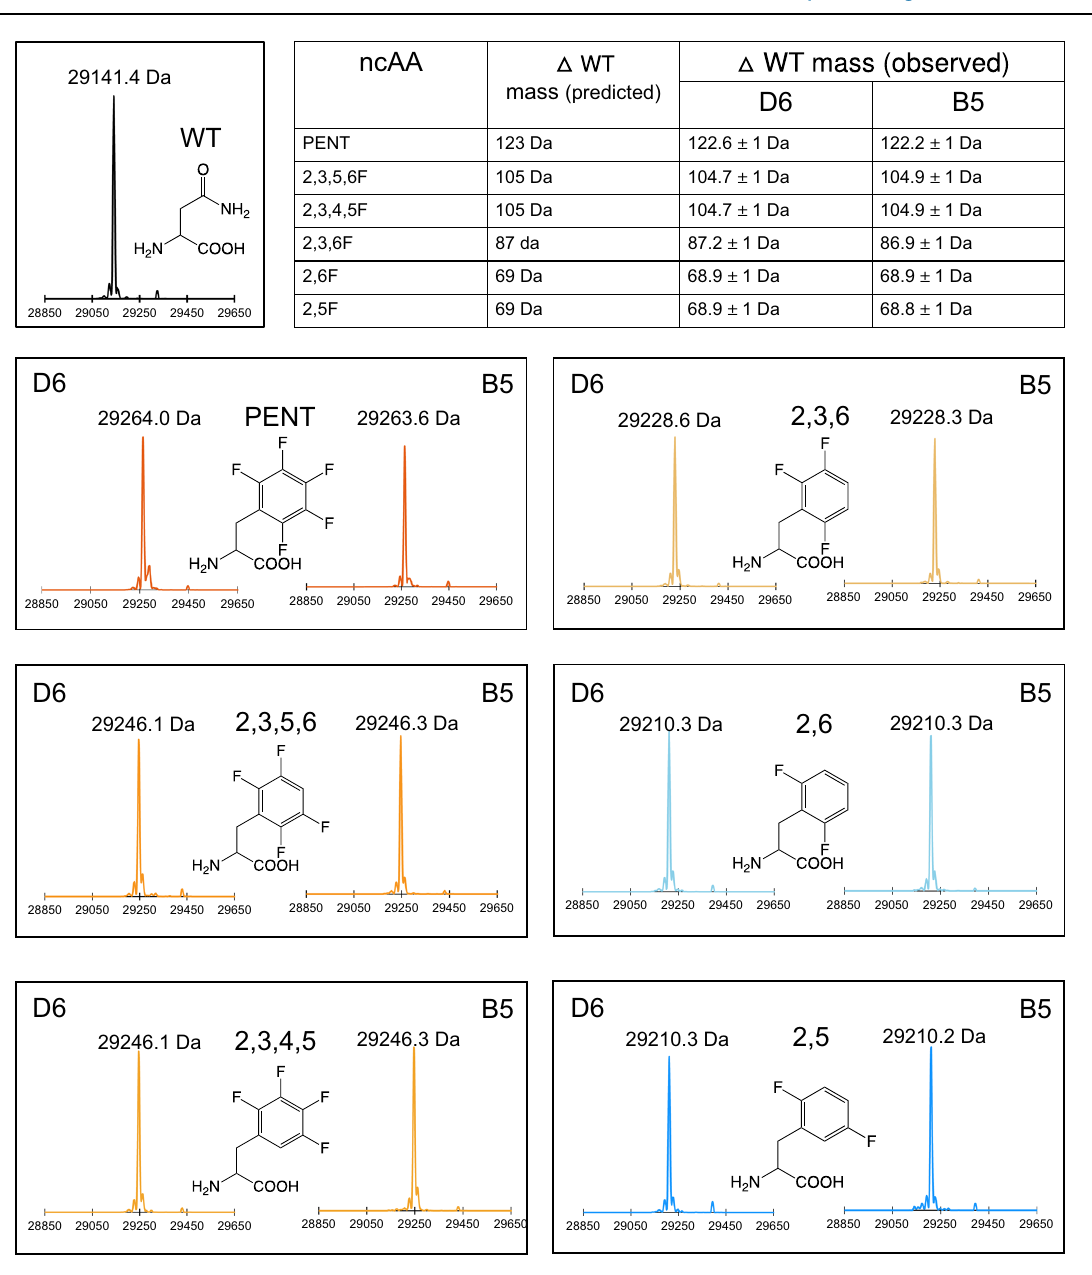
Fig. 6 | ESI mass spec con fi rmation of encoding of fl uorinated Phe analogs within sfGFP expressed in HEKT cells. ncAAs were added at 2mM concentration andcellswereharvestedapproximately36hposttransfection.sfGFP-WT-V5-HISor